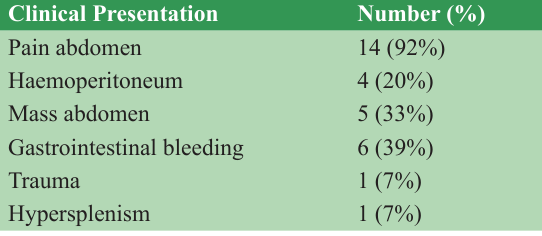
Table 1: Clinical